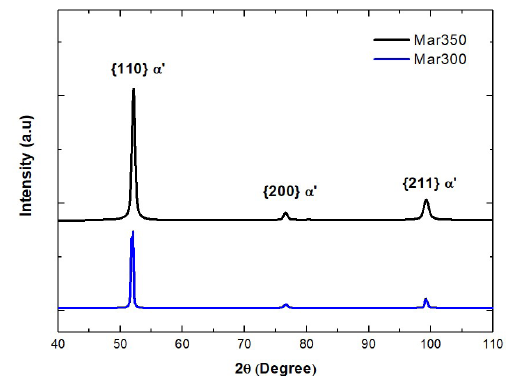
Figure 2. X-ray diffraction (XRD) spectra for the different reference maraging alloys investigated